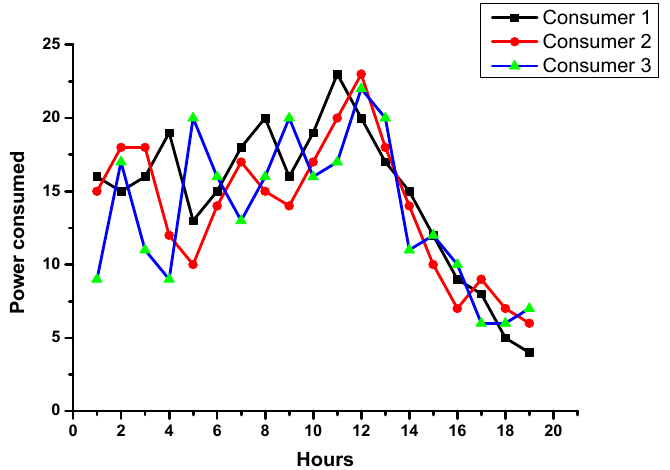
Figure 2. The total power consumed with the applied demand-response algorithm.